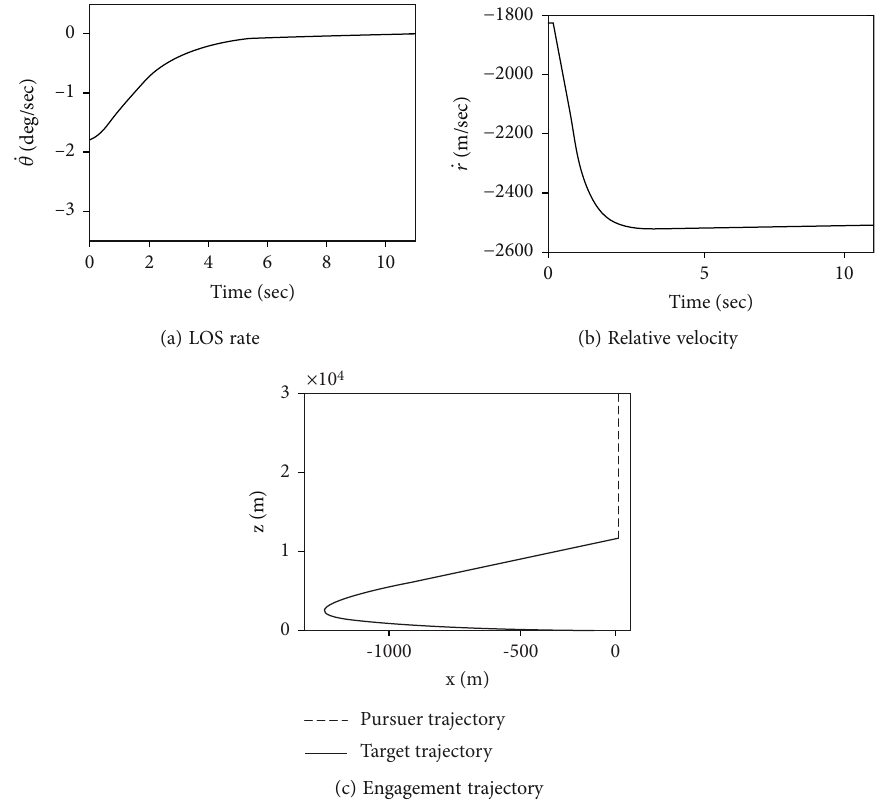
Figure 3: The engagement scenario against the nonmaneuvering